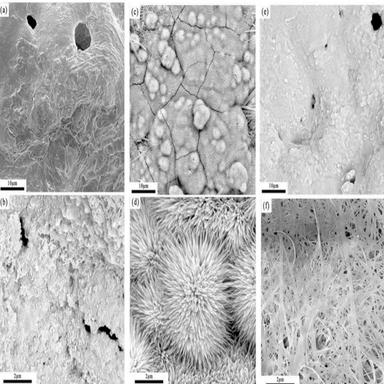
Surface morphologies of the (a, b) AO sample, (c, d) ED sample and (e, f) ST sample.